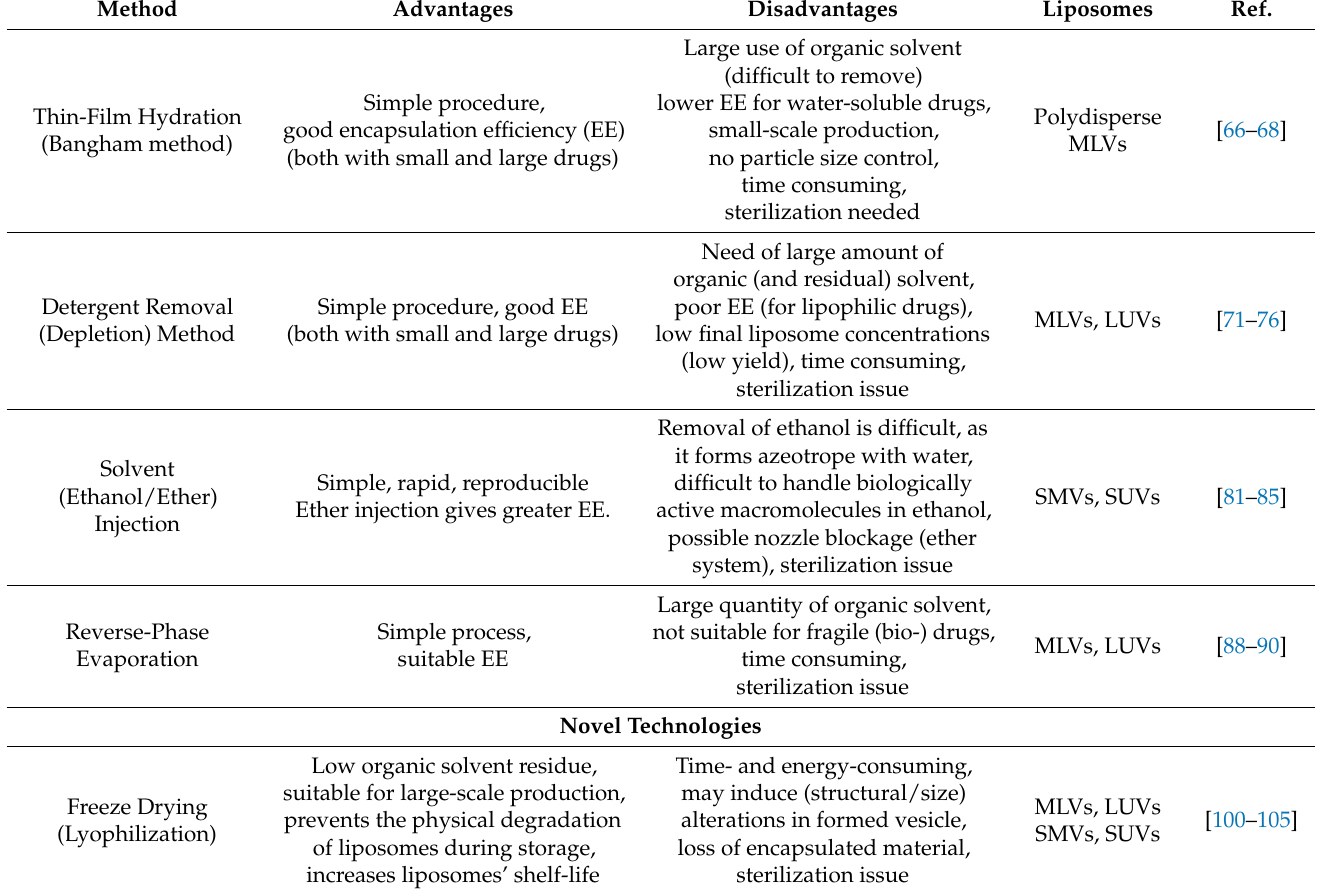
Table 1. Summary of the main features obtained by using different formation